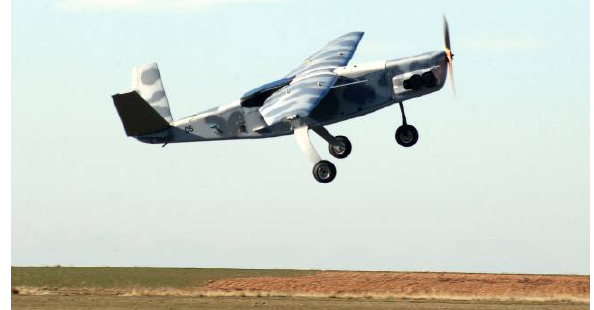
Figure 6. The SIVA unmanned aerial vehicle (INTA) solute navigation, based on point and crater extraction from images, respectively. Secondly, the representative environment consists on hardware/software integration into a UAV payload, including cameras, LiDAR and IMU, to perform in-flight testing of the development during the current